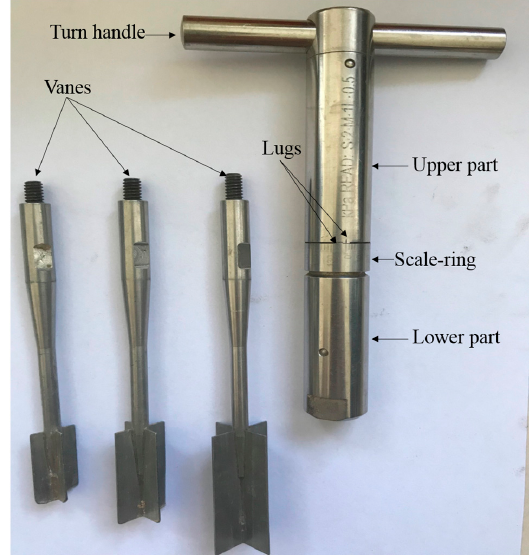
Figure 5. Field inspection vane tester device used for the shear strength tests.